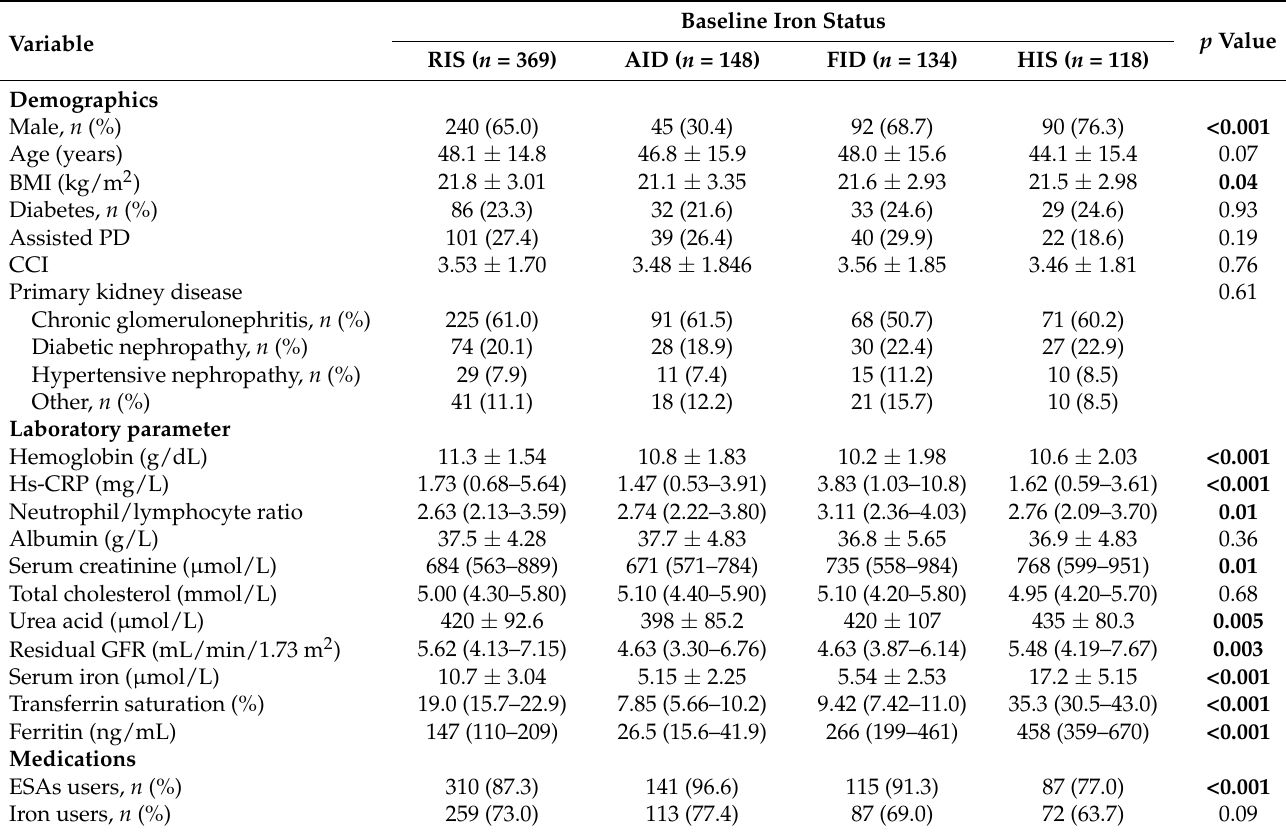
Figure 2. Definition of four iron statuses by joint TSAT and ferritin quartiles. Table 1. Baseline basic characteristics of